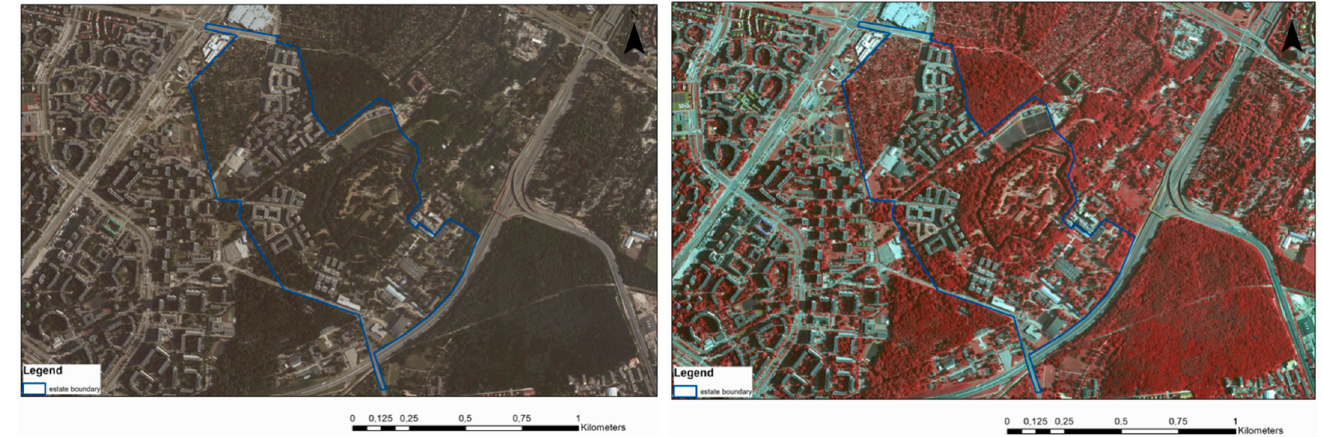
Figure 4. Visual composition with the housing estate and the NIR band (note: the blue colour indicates the boundaries of the housing estate FORT-BEMA, which is located in the western-northern part of Warsaw) [source: own elaboration based on orthophoto maps available on Geoportal— https://www.geoportal.gov.pl/, accessed on 2 November 2022].